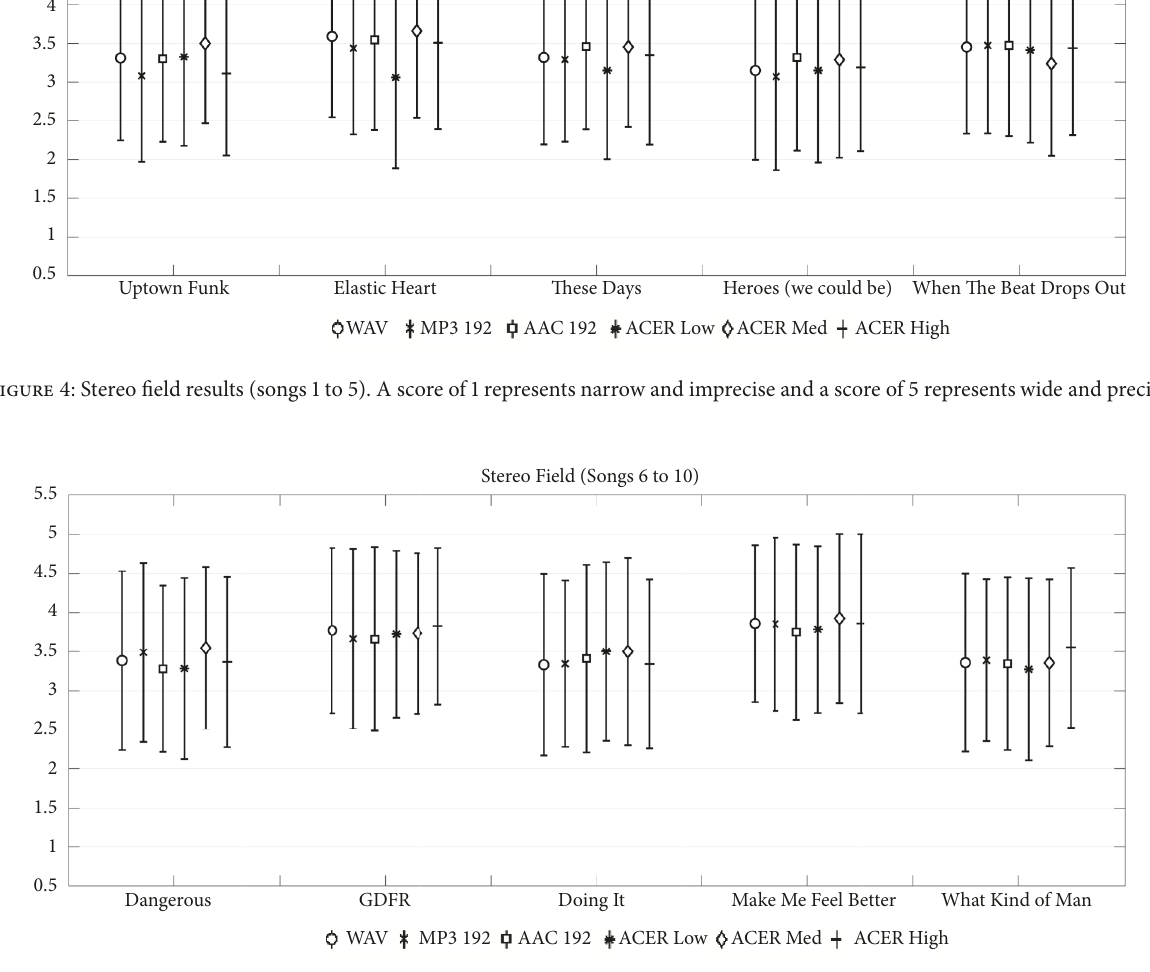
each of the coding approaches in terms of their perceived stereo